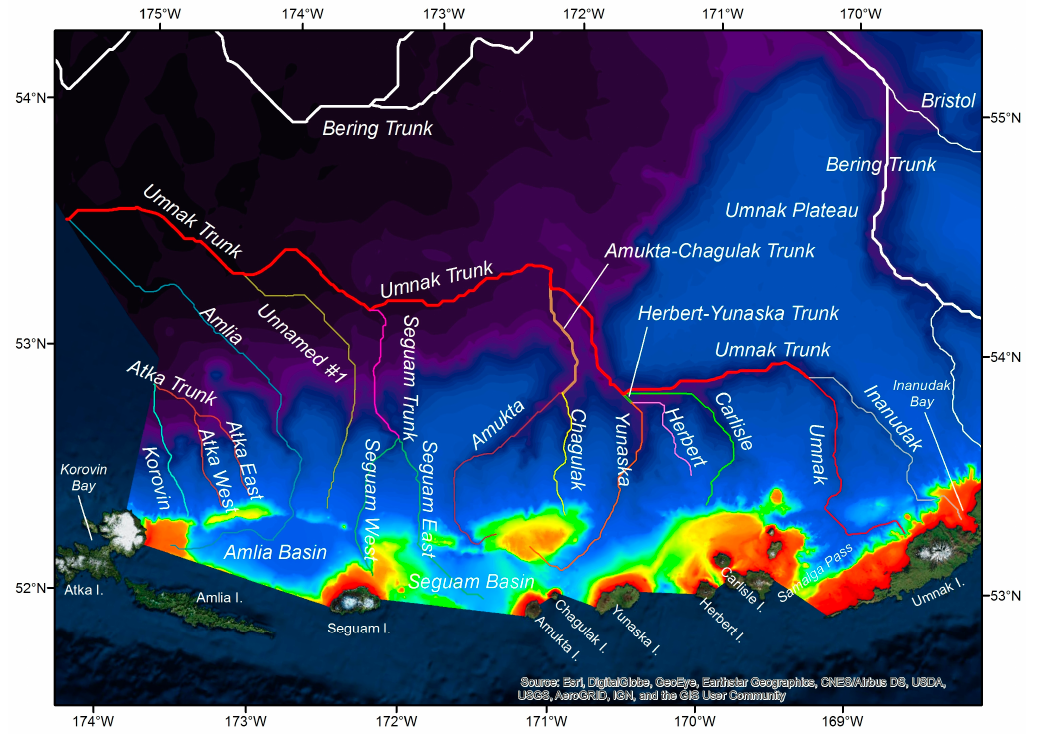
Figure 6. Thalwegs of the Umnak Canyon area of the eastern Bering Sea slope. Table 1. Umnak Canyon names and metrics described from west to east.